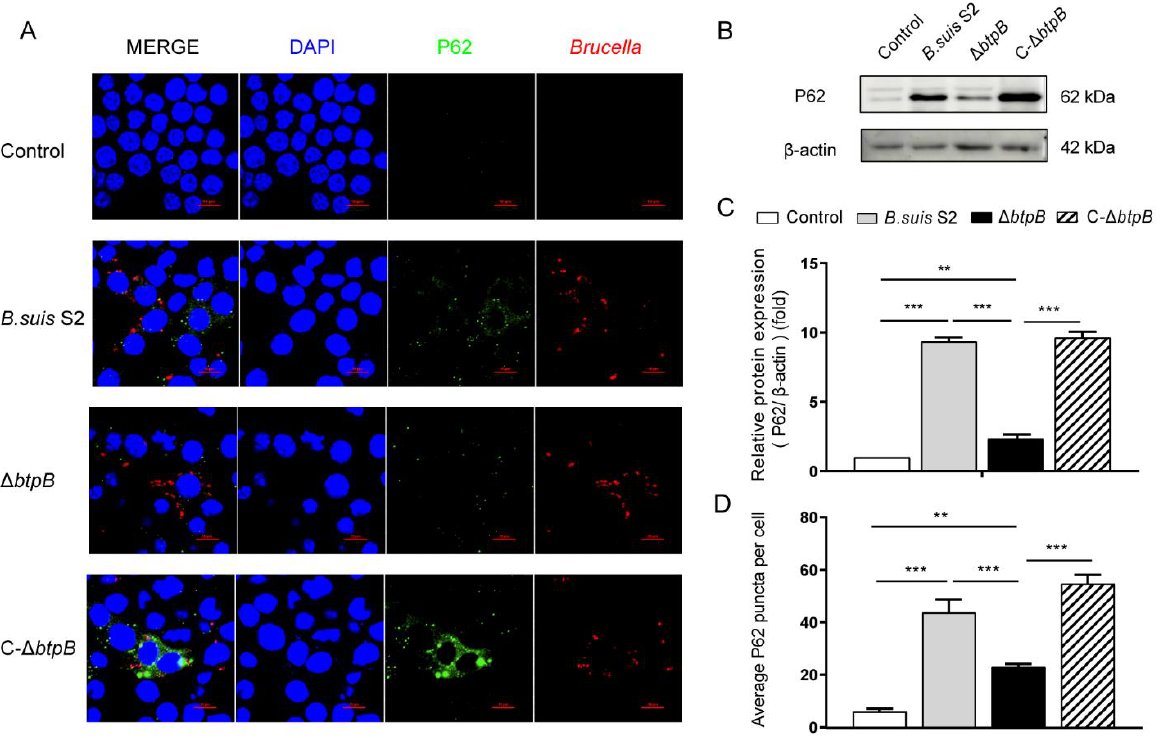
Figure 3. ∆ btpB inhibits the expression of P62 protein and P62 puncta. RAW264.7 cells were infected with Brucella strains (MOI = 200) for 24 h. ( A ) The P62 puncta were imaged by confocal immunofluorescence microscopy at 24 h after Brucella infection. Scale bars, 10 μm. ( B ) P62 and β -actin (loading control) expression levels were determined by immunoblotting with specific antibodies. ( C )